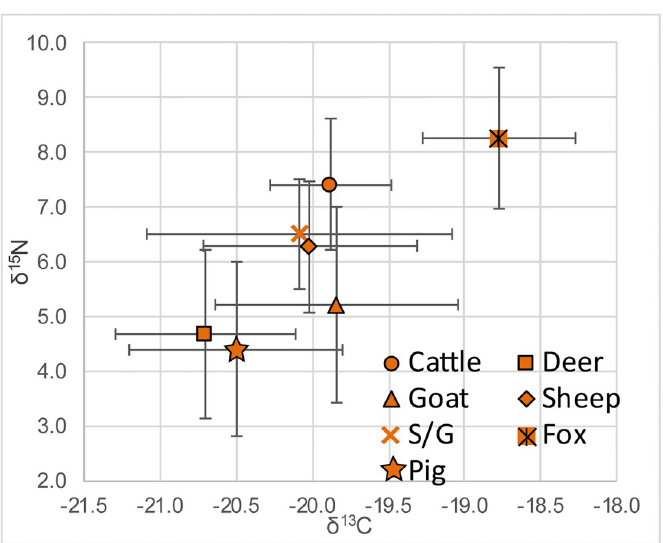
Fig 2. Means and standard deviations for δ 13 C and δ 15 N from bone collagen according to taxa at Politiko- Troullia , Cyprus. Bone collagen samples n = 140; deer (54), cattle (8), sheep (31), goat (27), sheep/goat (8), pig (8), fox